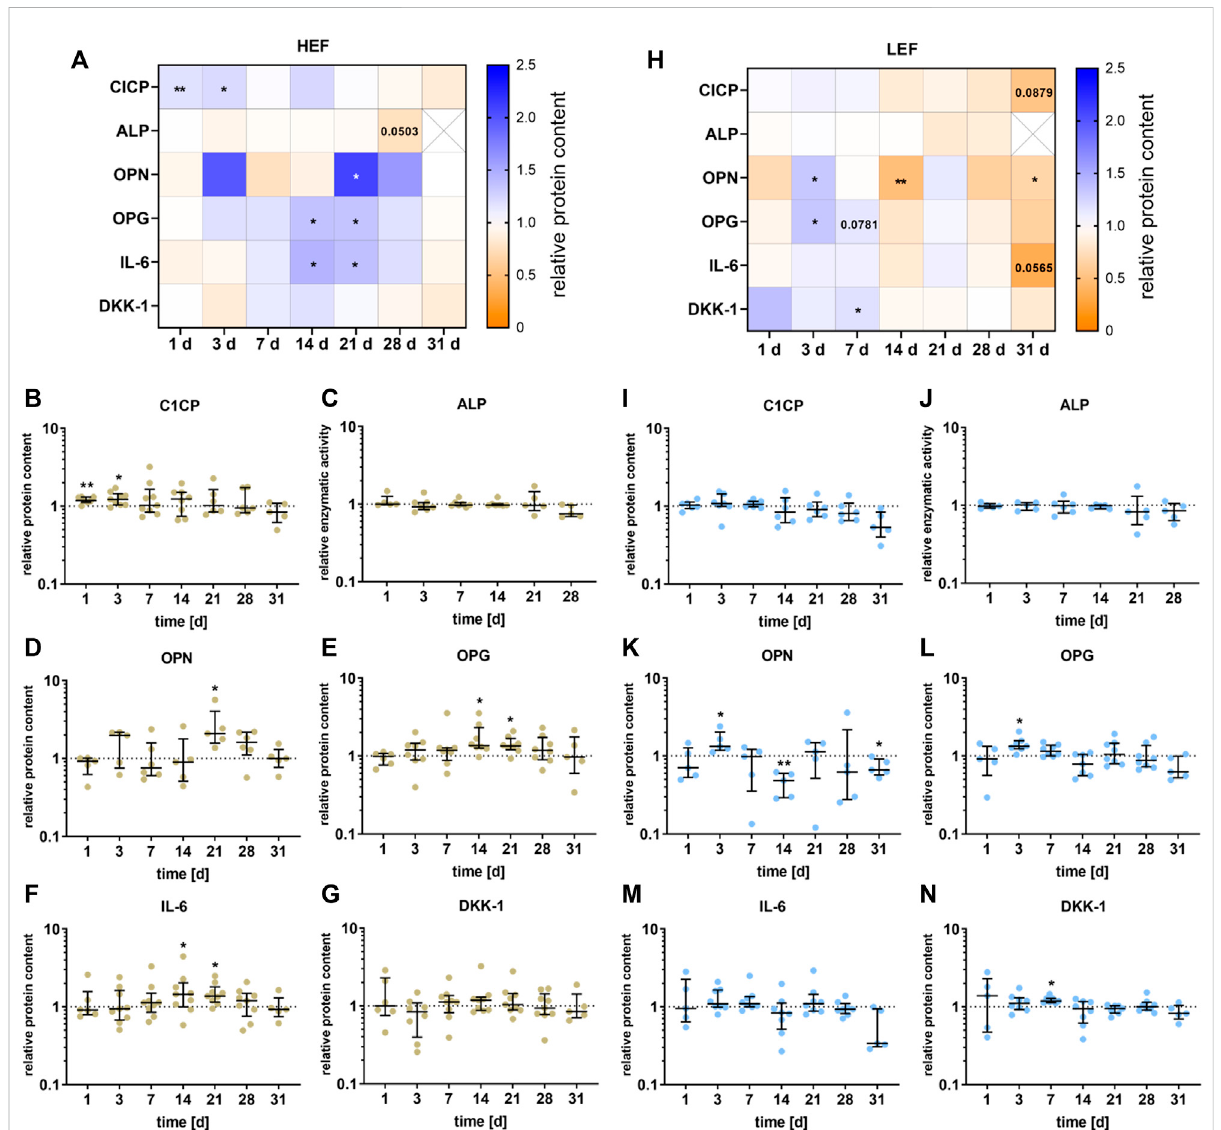
FIGURE 5 Secretion of proteins by pre-osteoblasts stimulated with two different electric fi eld strengths [ (A – G) higher electric fi eld: HEF, (H – N) lower electric fi eld: LEF] related to the unstimulated control. Pre-osteoblasts were stimulated over 31 days. The analysis time points were 1, 3, 7, 14, 21, 28 (forALP),and31 days(forCICP,OPN,OPG,IL-6,andDKK-1)withassaysperformed20 hafterthelaststimulationintervalstarted.Proteinlevelswere acquired for CICP, OPN, OPG, IL-6, and DKK-1 from the supernatant and related to the total protein content of the supernatant. The activity levelofALPwasgeneratedthroughthelysisofthecells.Theunstimulatedcontrolofeachtimepointwasusedfornormalization. (A,H) Resultswithin heatmapsareshownasmedianswherebythedownregulationisidenti fi edinorange[ < 1],theupregulationinblue[ > 1],andasimilarproteinsecretion asthecontrolinwhite[=1]. (B-G,I-N) Thedistributionofthetotalresults[ n ≥